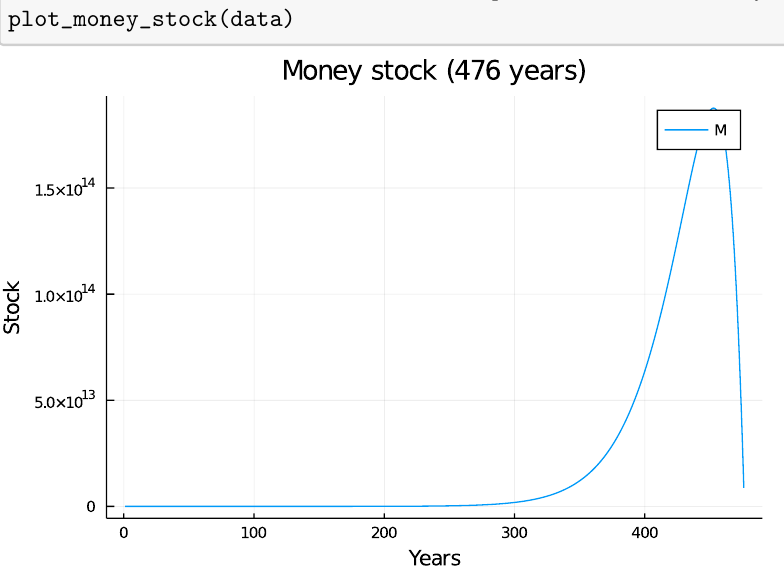
Figure 13. Debt ratio (LR = 15%, p = 0.9%, m = 20 years). LR = 14.9%, p = 0.8%, m = 20 years data = simulate_fixed_LR(LR = 0.149, p = 0.008, m = 20, cycles = 500)